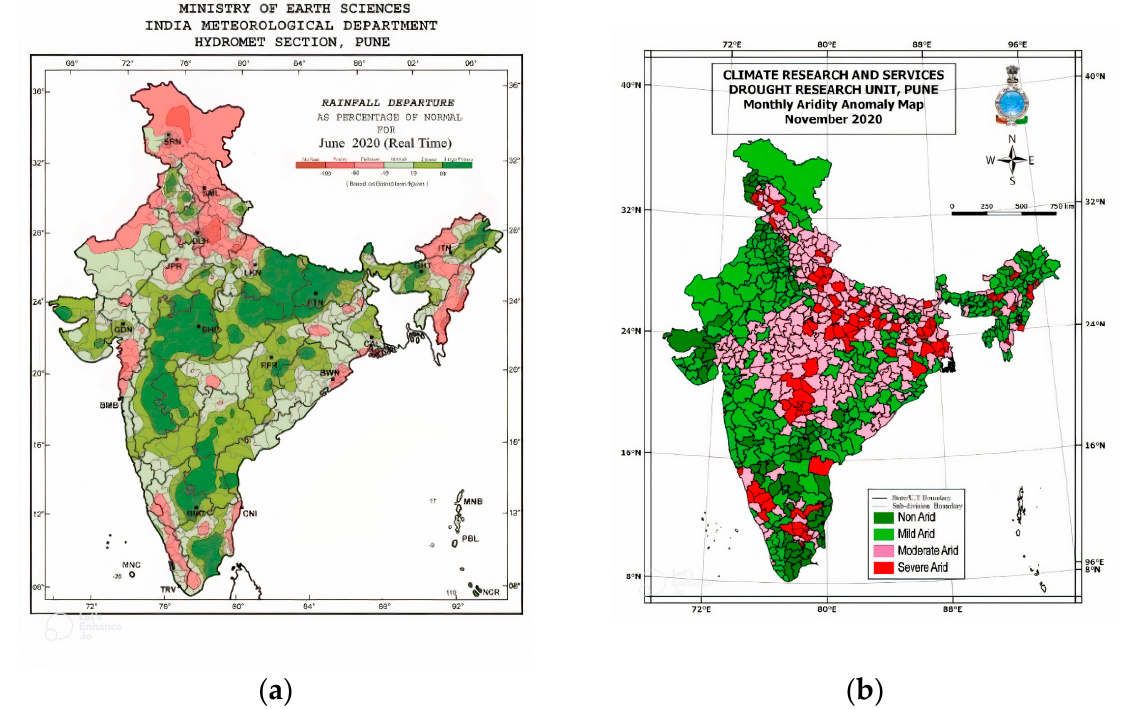
Figure 2. Rainfall and drought status of India. ( a ) Rainfall deviation from normal in June 2020 (Source: IMD, Pune https://www.imdpune.gov.in/hydrology/pdc.html). ( b ) Drought in November